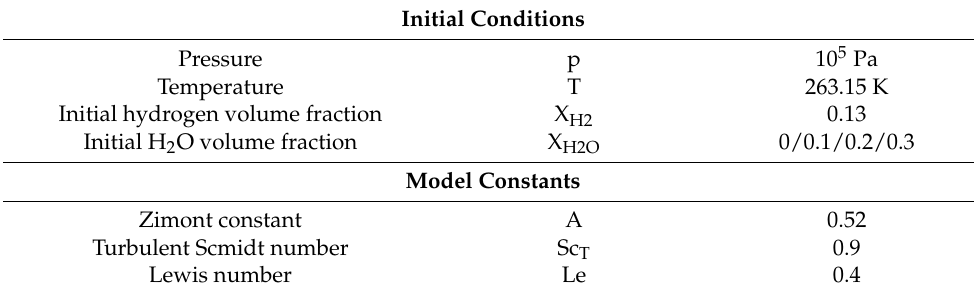
Table 1. Initial data.